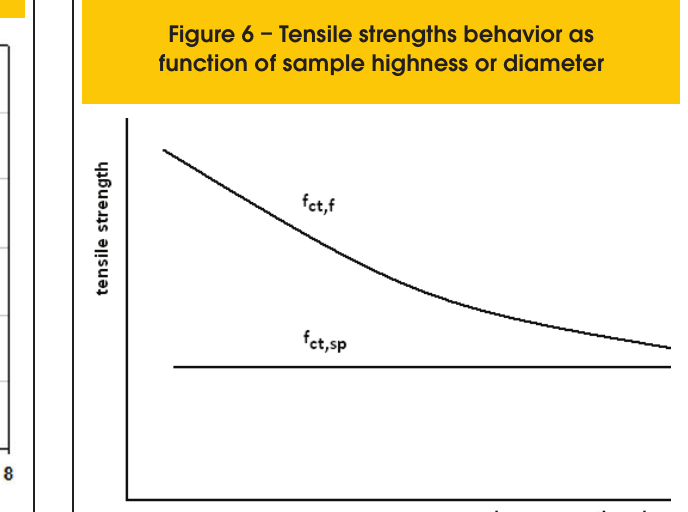
Figure 6 – Tensile strengths behavior as function of sample highness or